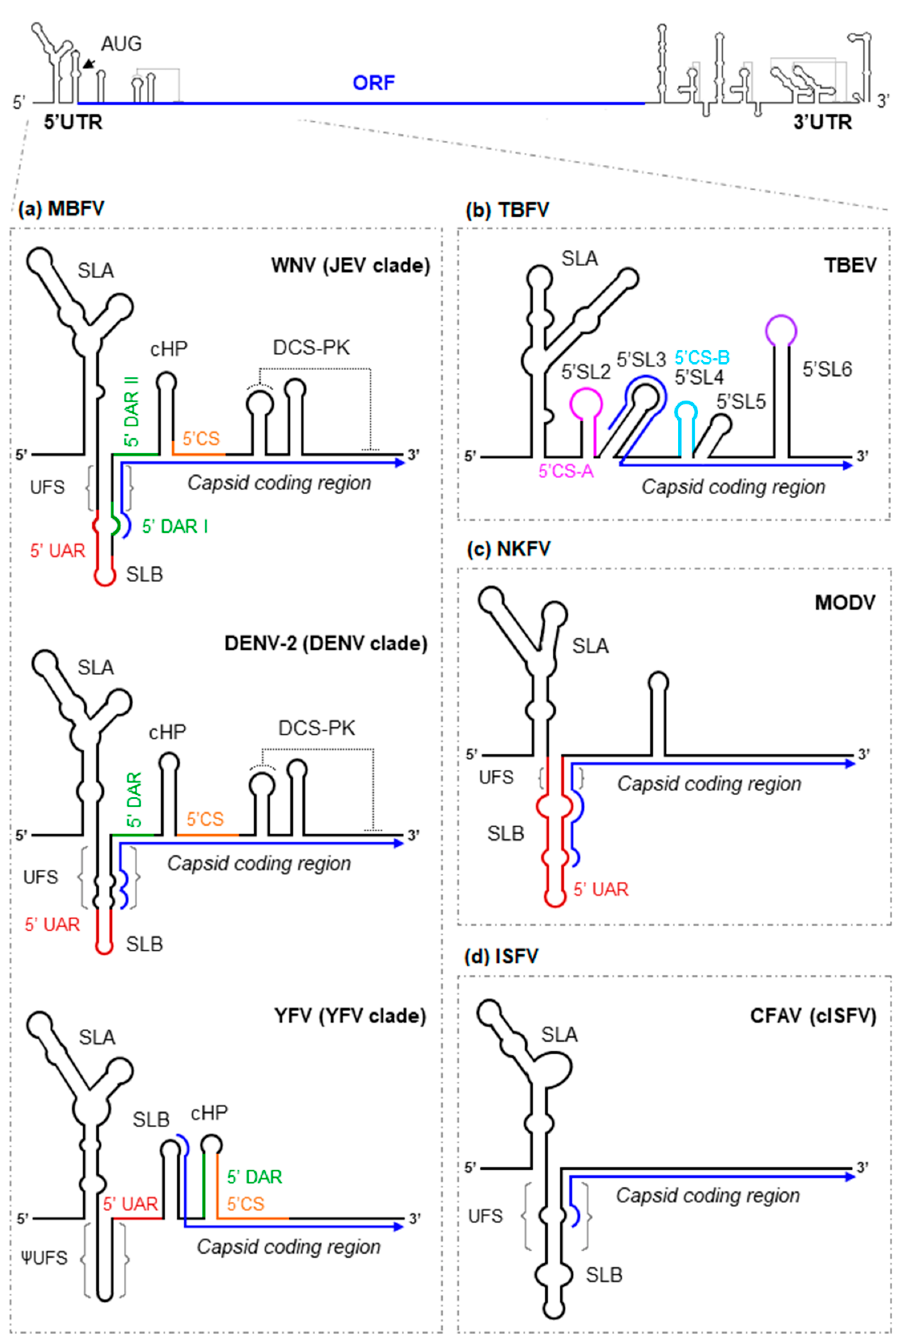
Figure 1. Structural RNA elements of the 5 (cid:48) end of representative flavivirus genomes. As a model for flaviviruses, a diagram of the WNV genome is shown at the top of the figure. The arrowhead indicates the position of the AUG translation initiation codon. The ORF is represented by a thick